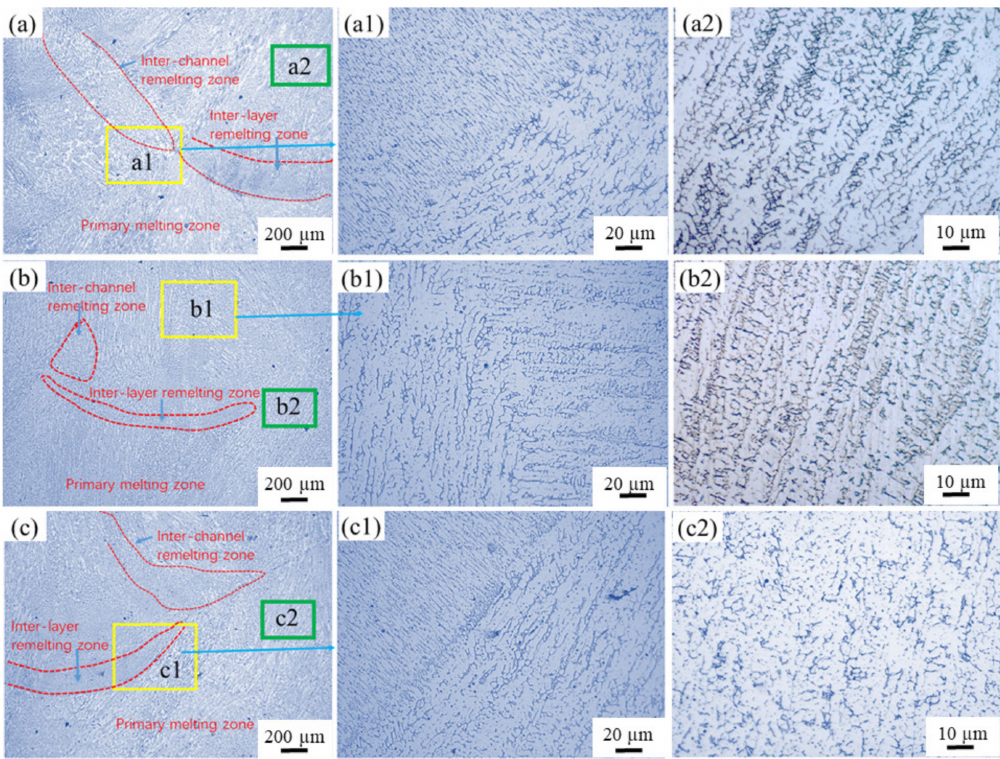
Figure 4. Microstructure between welding traces of 321 stainless steel printed workpiece. ( a – c , a1 – c1 , a2 – c2 ) are the metallographic structures of the top, middle, and bottom samples, re-